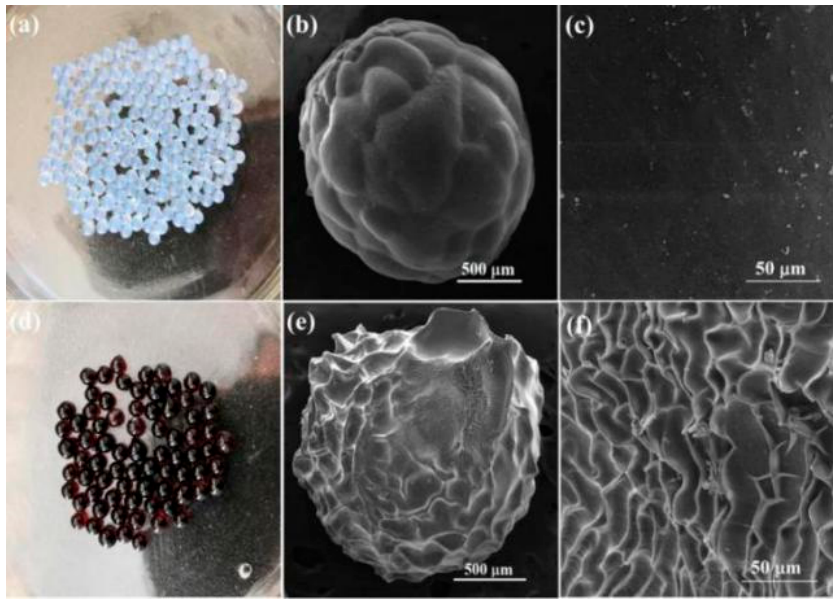
Figure 1. Photos ( a ) and SEM images ( b ) ×100, ( c ) ×1000 of pure SA beads, photos ( d ) and SEM images ( e ) ×100, ( f ) ×1000 of SA/Lig-20% beads.